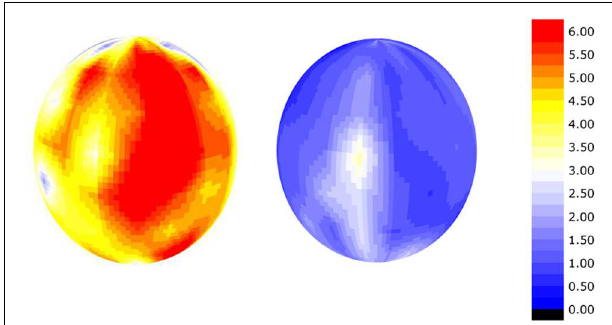
FIGURE 6 | Smoothed semi-quantitative potassium:calcium ratio on the surface of a apple affected by bitter-pit (left) and a healthy apple (right) calculated as the rhodium-normalized PXRF counts for potassium divided by the rhodium-normalized PXRF counts for